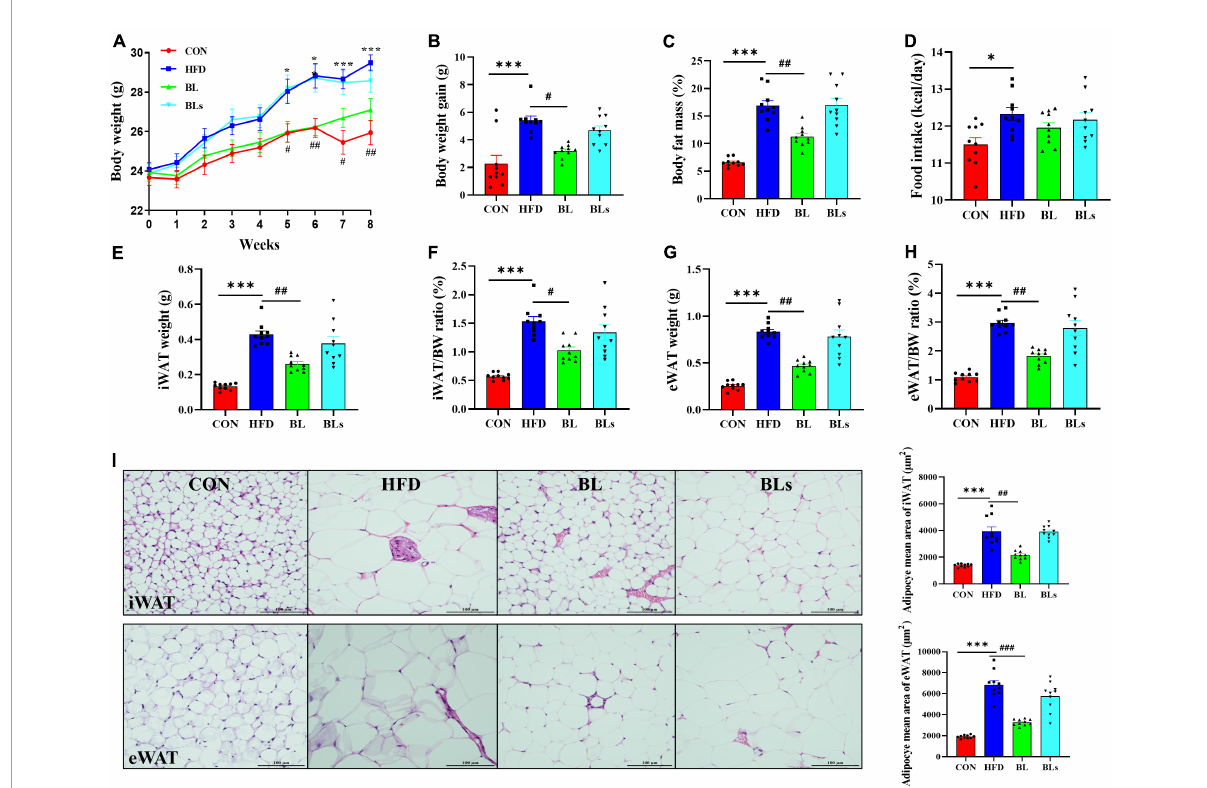
FIGURE1 Brevibacillus laterosporus BL1 treatment reduced body weight gain and fat accumulation in HFD-fed mice. (A) Body weight, (B) body weight gain, (C) body fat mass, (D) food intake, (E) iWAT weight, (F) iWAT/BW ratio, (G) eWAT weight, (H) eWAT/BW ratio, (I) H and E staining of iWAT and eWAT sections. Scale bar = 100 µ m. Data are presented as mean ± SEM ( n = 10) and analyzed using one-way ANOVA. Significant differences between HFD and CON are indicated by ∗ p < 0.05 and ∗∗∗ p < 0.001. Significant differences between HFD and BL are indicated by # p < 0.05, ## p < 0.01, and ### p <